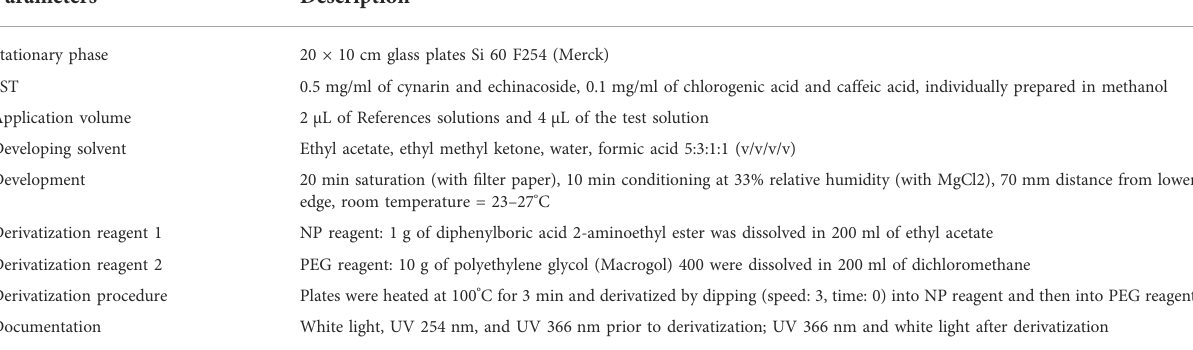
TABLE 2 HPTLC parameters for identi fi cation of cone fl ower roots and aerial parts, phenolic compounds fi ngerprint.